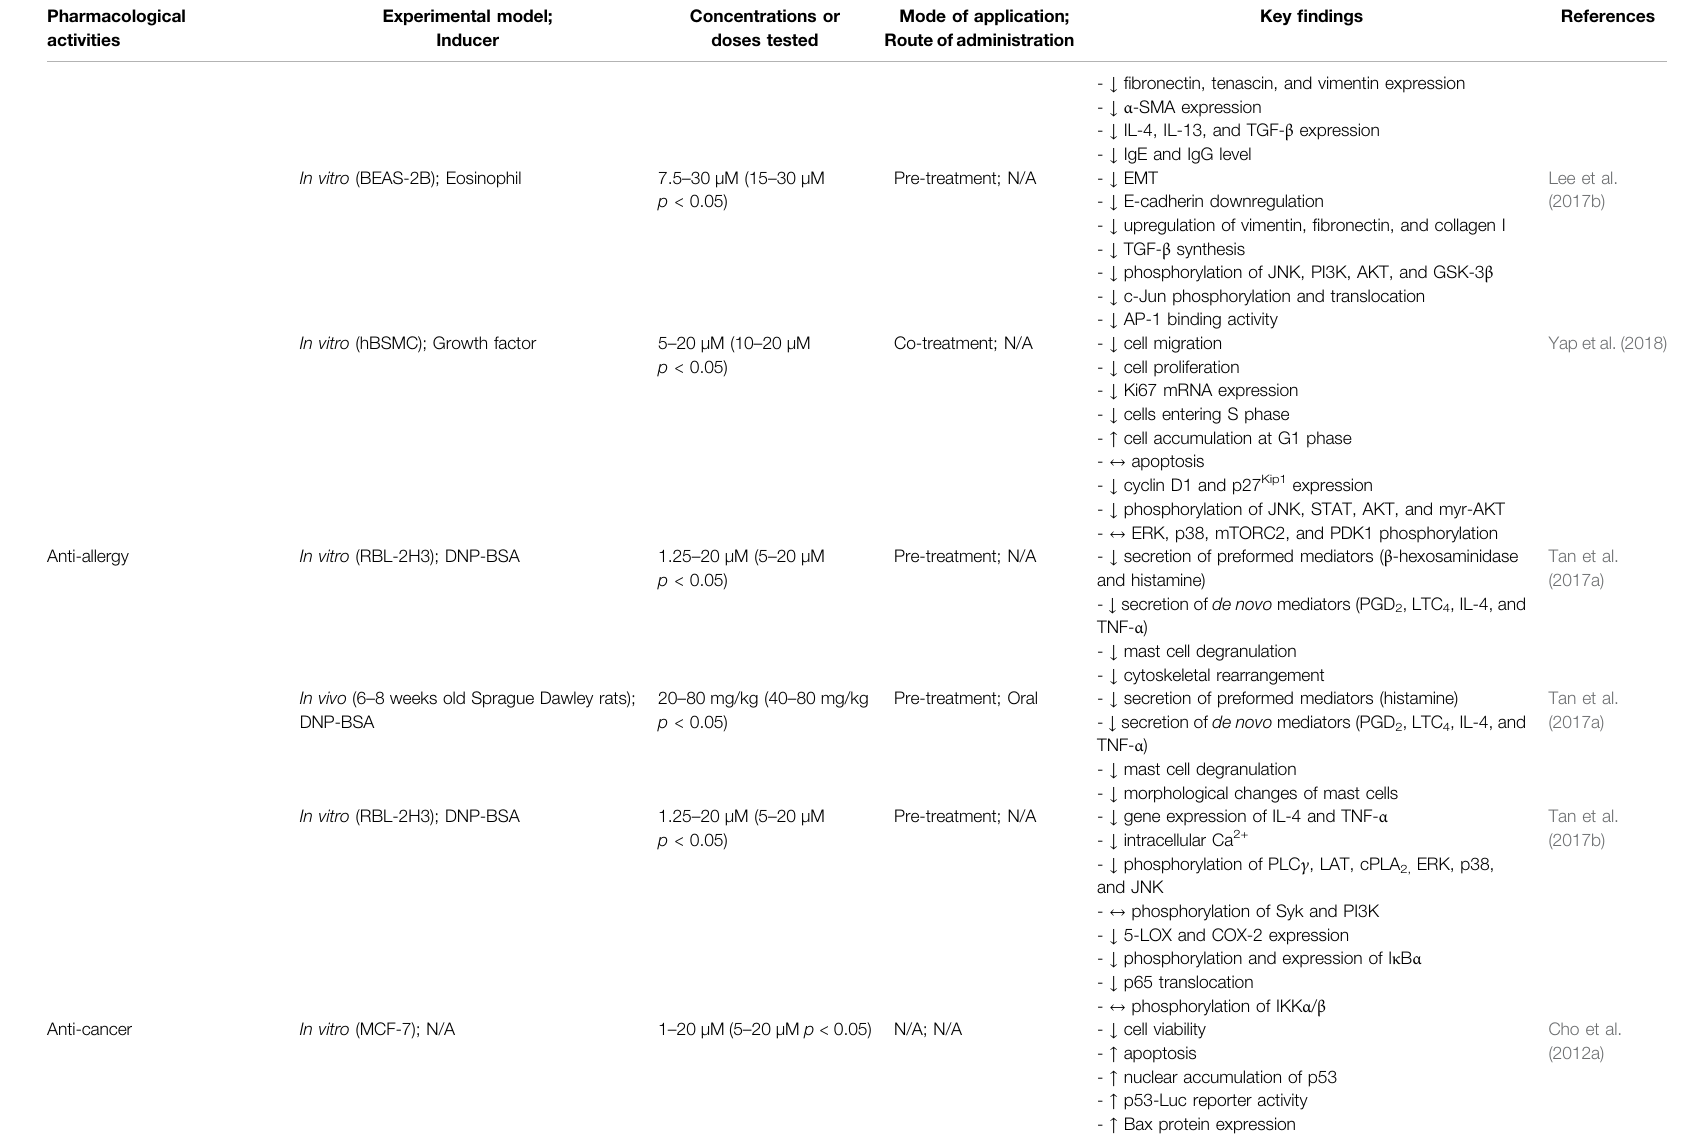
TABLE 1 | ( Continued ) Pharmacological activities of tHGA and the key fi ndings reported in various studies with different experimental